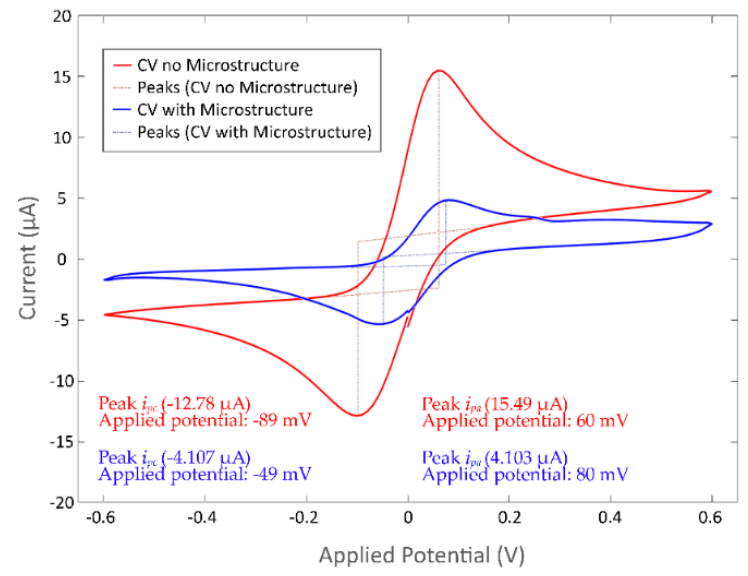
Figure 5. Cyclic voltammograms of ferro / ferri solution using the microelectrodes before (red) and after (blue) the fabrication of the confinement structure.